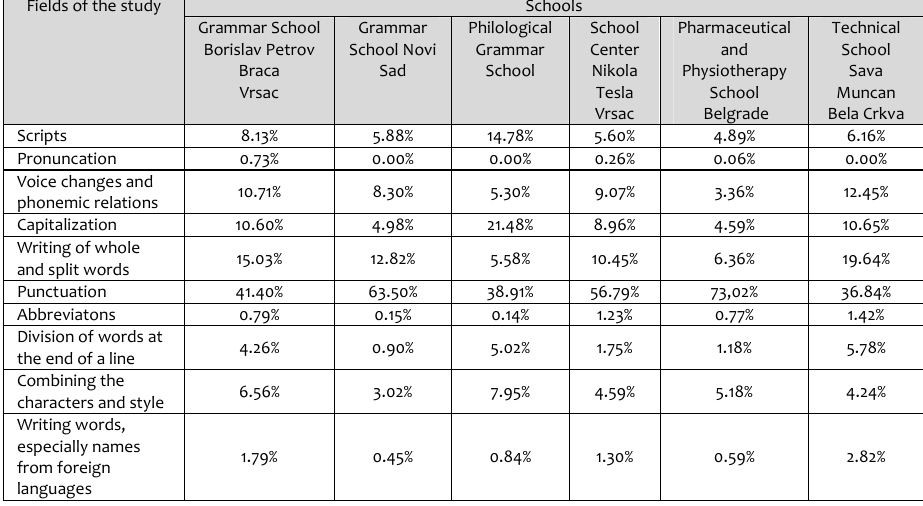
Table 6 Overview of the percentage of different types of orthographic mistakes in written assignments of secondary school students in respect to the schools they